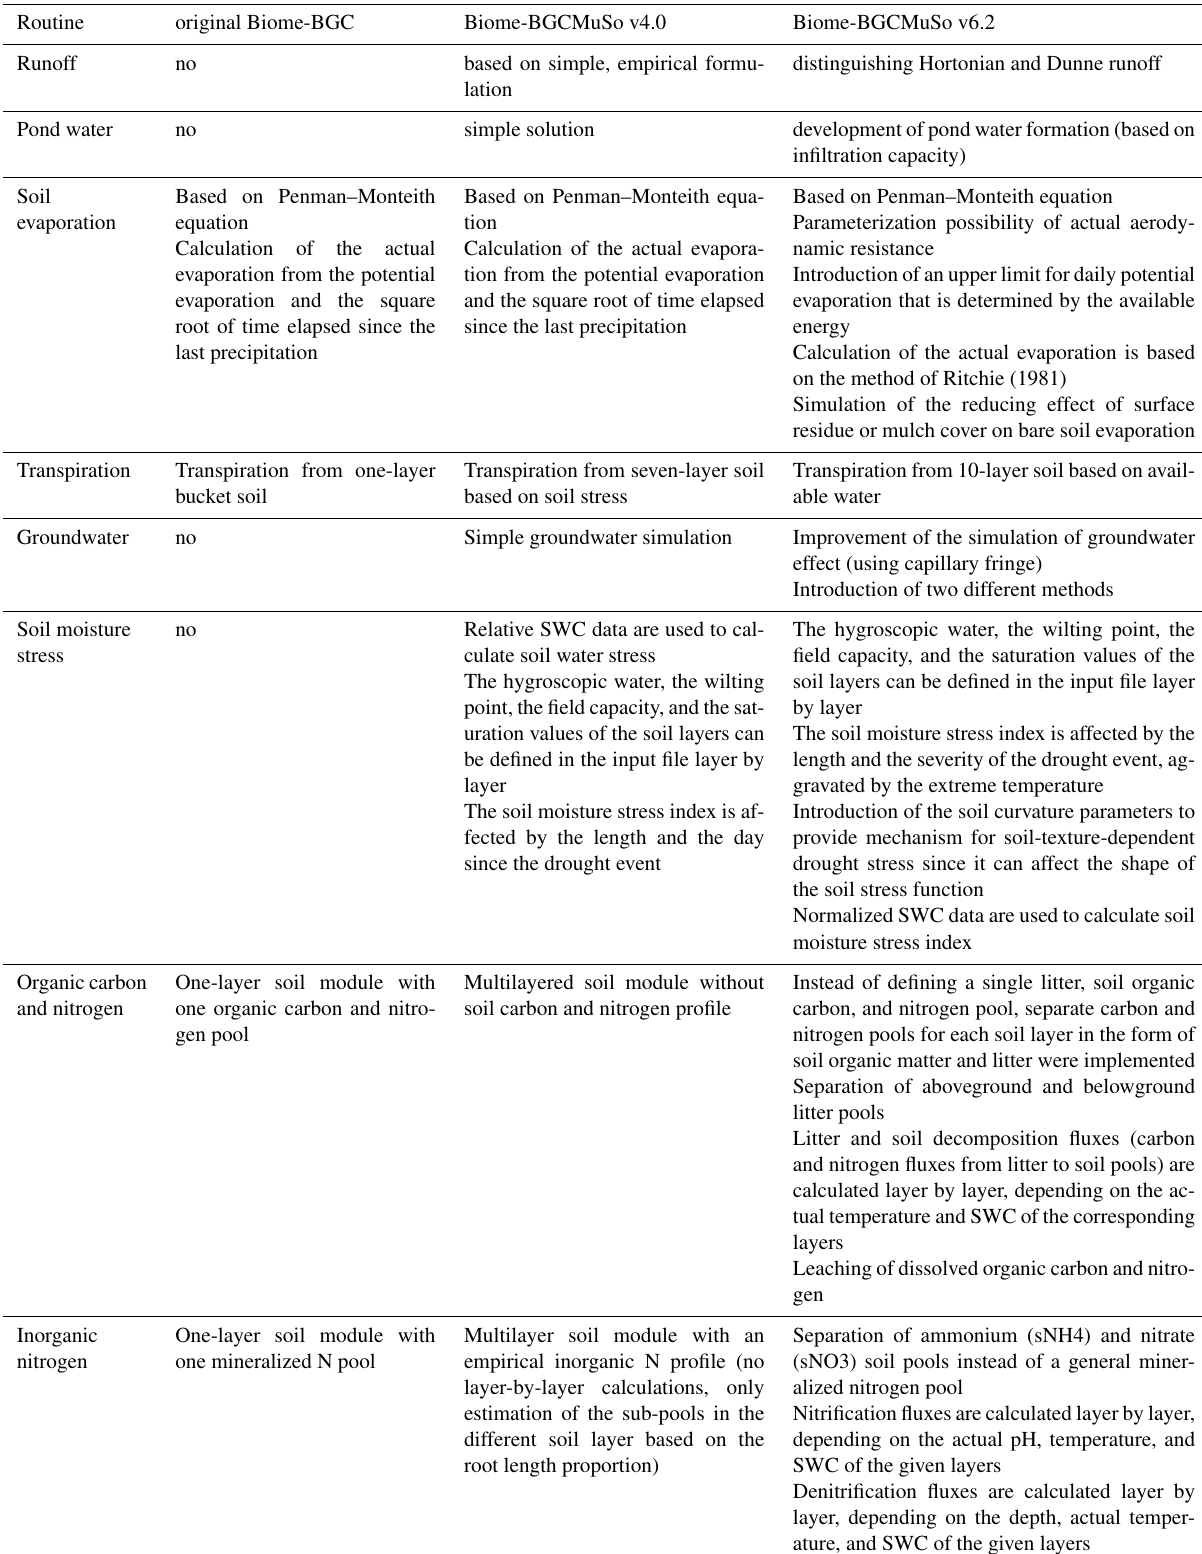
Table 2. Comparison of the internal processes simulated in Biome-BGC 4.1.1, Biome-BGCMuSo v4.0, and Biome-BGCMuSo v6.2.